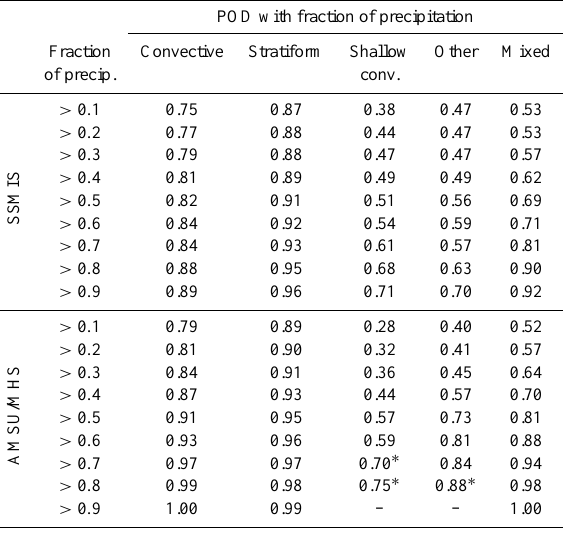
Table 5. Probability of detection scores classified by rain type and percentage of precipitation in the pixel. No results are provided for samples with less than 100 pixels.